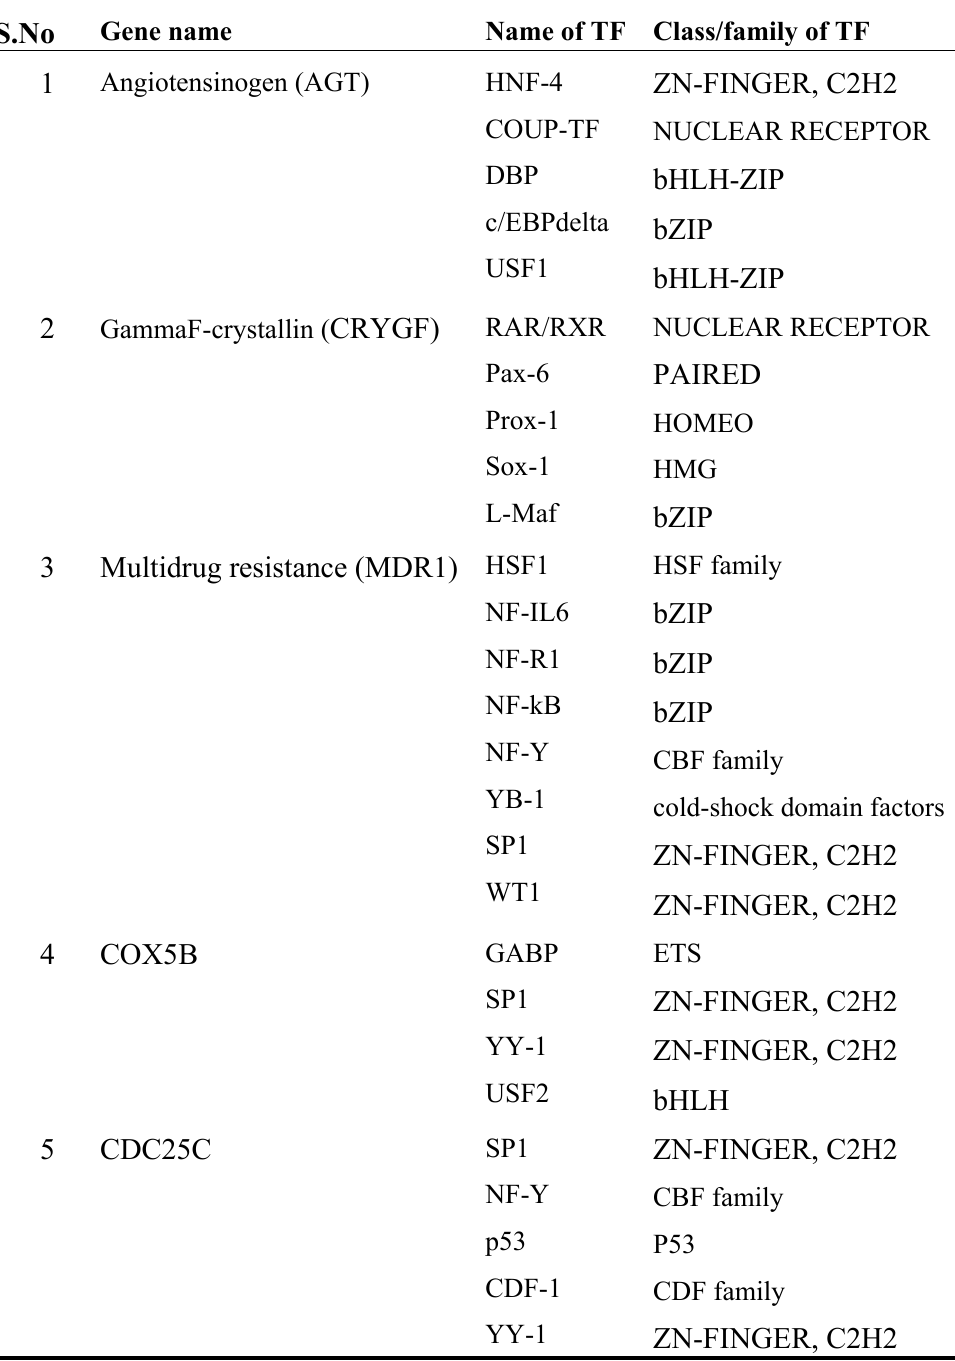
Table 4: Human gene with number of TFs involved for their regulation and class/family name of TFs (Data is extracted from TRRD database [29])